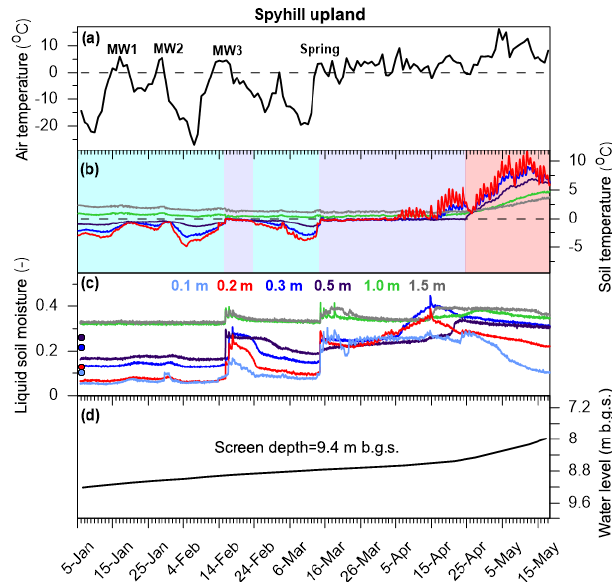
Figure 9. Temporal variability of hydrologic variables during the monitoring period for the Spyhill upland location showing (a) the average daily temperature and identification of snowmelt events; (b) soil temperatures; (c) liquid soil moisture, with pre-freezing values shown as circles; and (d) groundwater level measured in piezometers, with the screen depth indicating the midpoint of the screen interval. In panel (b) , blue shading indicates frozen ground, purple indicates partially frozen ground, and red indicates unfrozen ground.